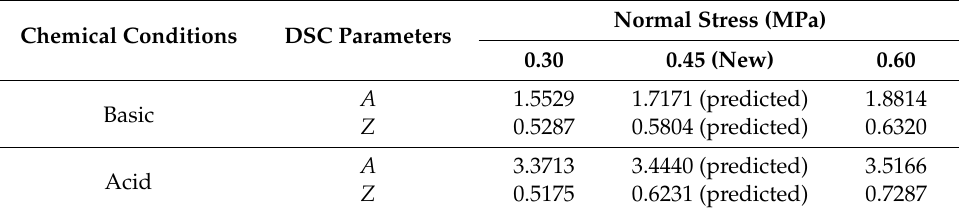
Table 6. Additional test conditions for verification.